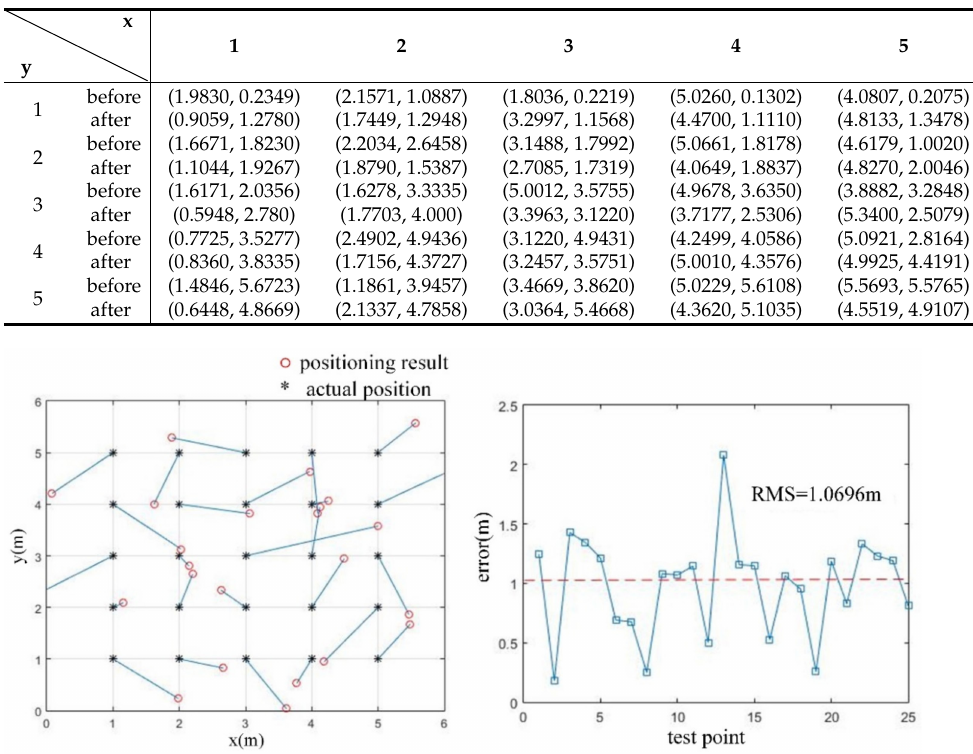
Table 2. Positioning results of collected fingerprint area.